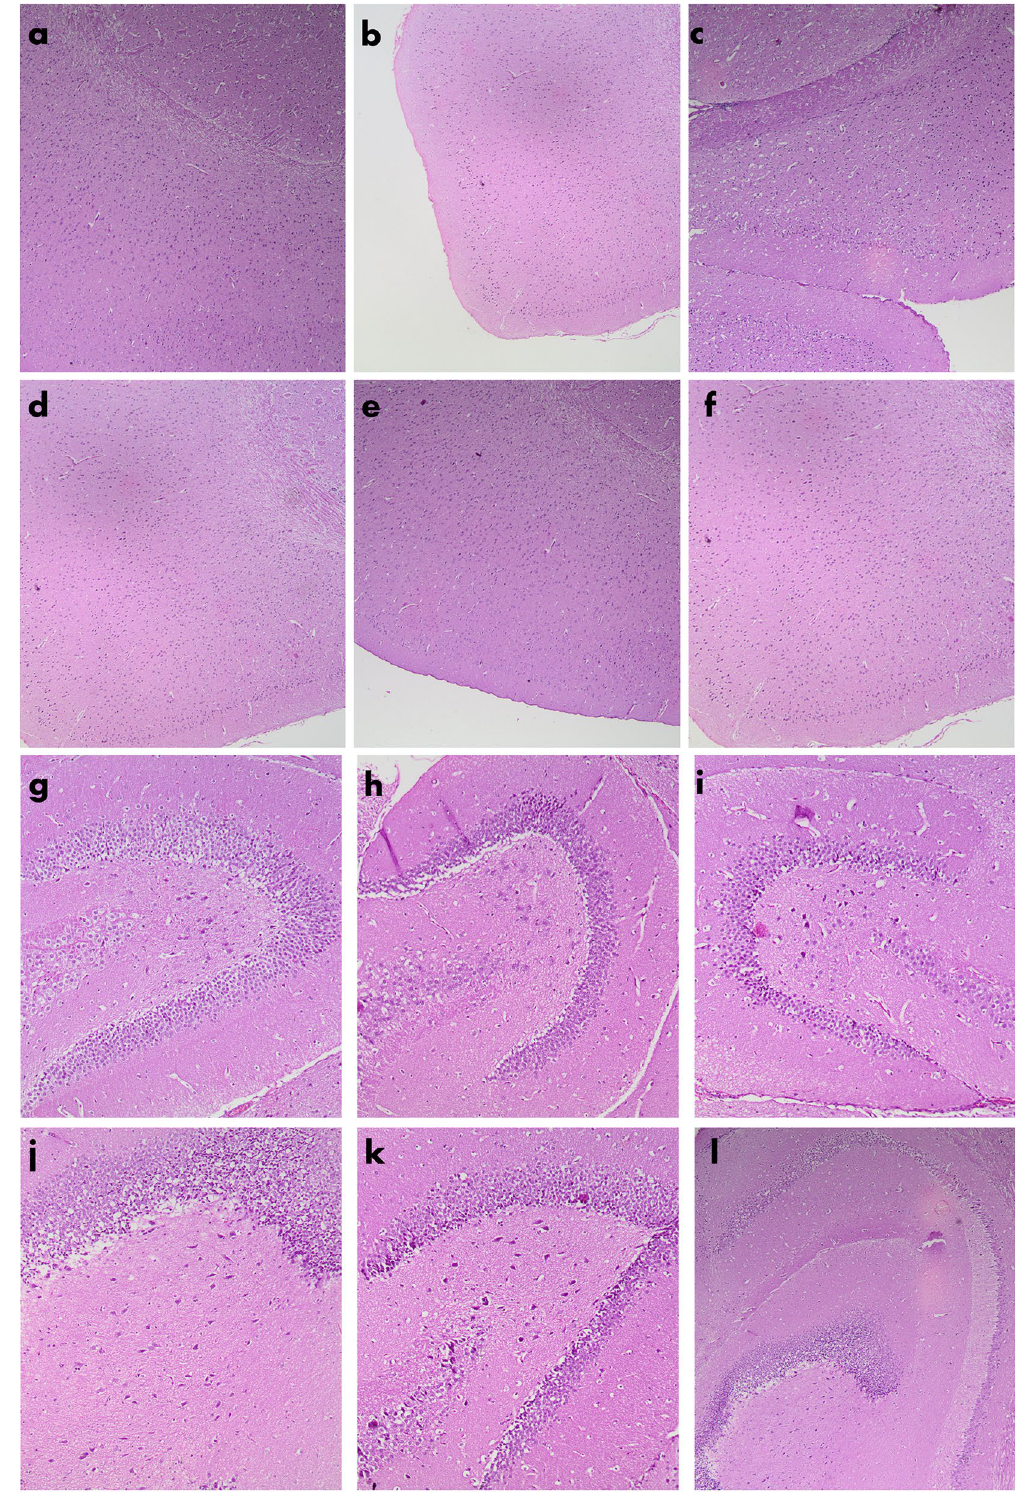
Figure 5. H&E stain of brain tissue of BALB/c mice in all experimental groups. Sections ( a – f ) show parts of the cortex of the following groups sham, saffron sham, crocin sham, TBI, saffron TBI, and crocin TBI respectively (4×). Sections ( g – l ) show parts of the denta gyrus of the following groups, sham, saffron sham, crocin sham, TBI, saffron TBI, and crocin TBI respectively (10×). Sections ( m – r ) show parts of the cerebellum of the following groups, sham, saffron sham, crocin sham, TBI, saffron TBI, and crocin TBI respectively (20×). Sections ( s – x ) show parts of the corpus collosum of the following groups, sham, saffron sham, crocin sham, TBI, saffron TBI, and crocin TBI respectively (20×). All sections appear without any neuronal loss and without any axonal spheroids among all groups. No evidence was shown for tissue loss, contusions, edema, or intraparenchymal hemorrhages in sections of all groups. All sections shown were obtained after 7 days from the final